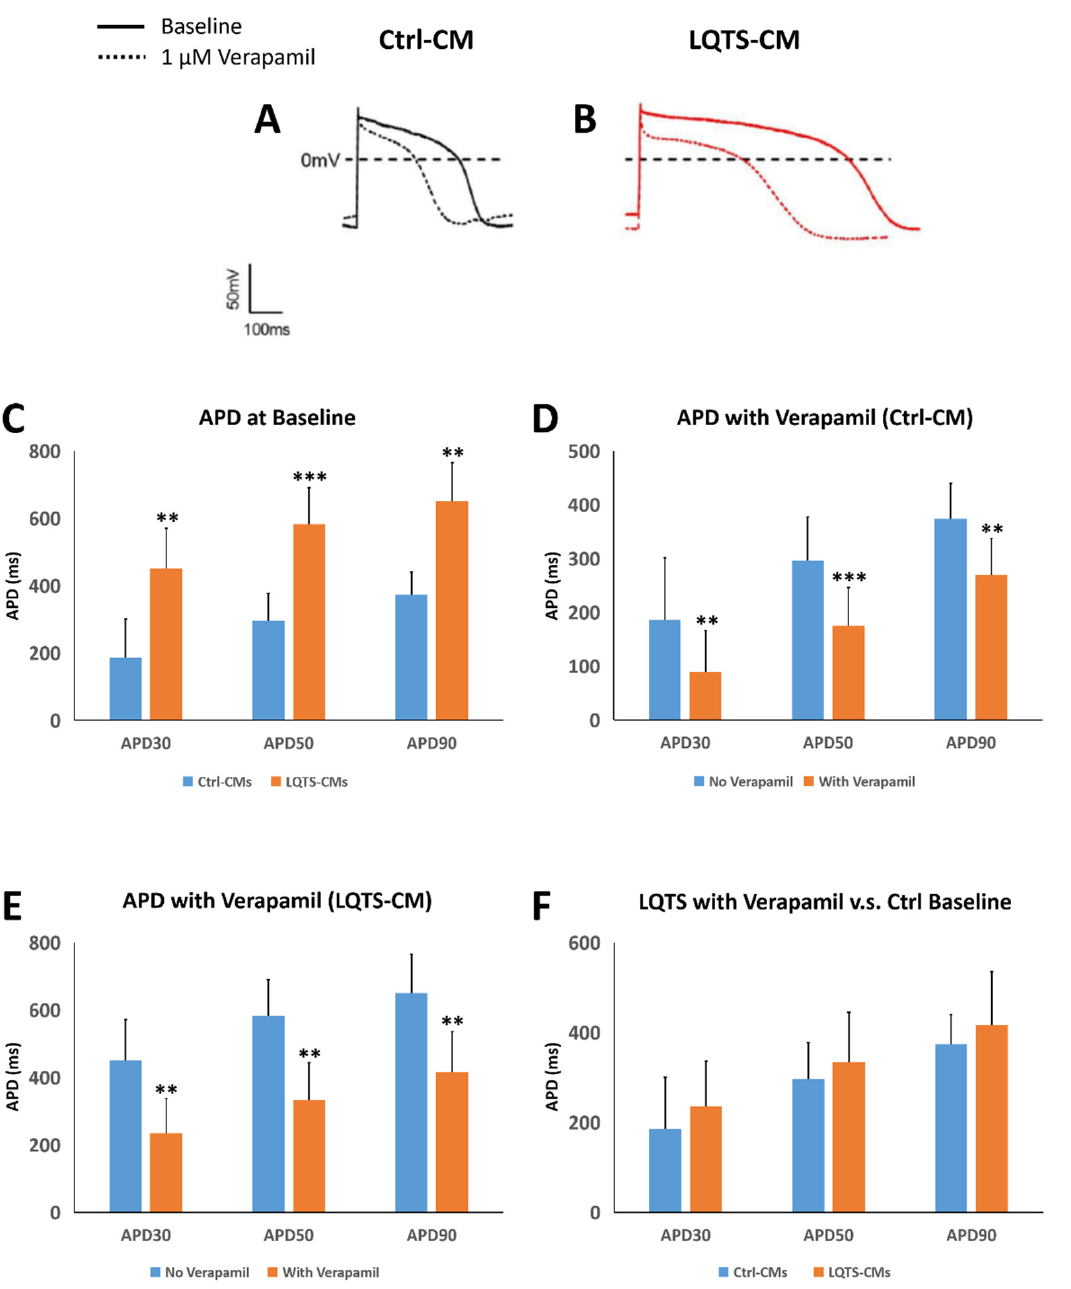
Figure 4. Electrophysiological Analysis of Verapamil Treatment. Whole cell patch clamp revealed APD profiles of Ctrl-CMs ( A ) and LQTS-CMs ( B ), respectively. Without any treatment, LQTS-CMs demonstrated significantly longer QT intervals than Ctrl-CMs in terms of APD 30 , APD 50 and APD 90 ( C ). Treatment of 1 μ M verapamil resulted in significant reduction of APD 30 , APD 50 and APD 90 in Ctrl-CMs ( D ) and LQTS-CMs ( E ). APD 30 , APD 50 and APD 90 of LQTS-CMs treated with 1 μ M verapamil demonstrated no statistically significant difference when compared to APD values of Ctrl-CMs at baseline ( F ). Cardiomyocyte action potential graphs and immunofluorescence images are representative samples. All experiments were of n = 3 or larger. ** = p ≤ 0.01; *** = p ≤ 0.005.